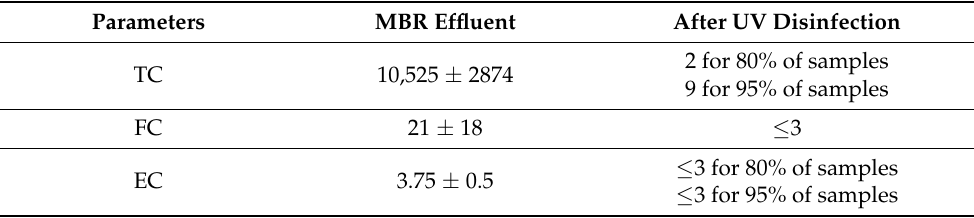
Table 5. UV performance (concentrations in cfu/100